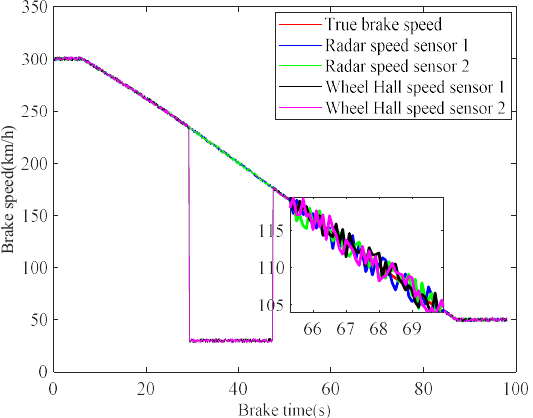
Figure 18. Train braking speed measurements.